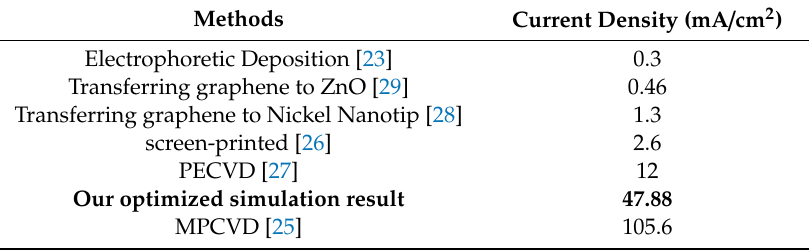
Table 1. Field emission current density of graphene array cathodes prepared by di ff erent